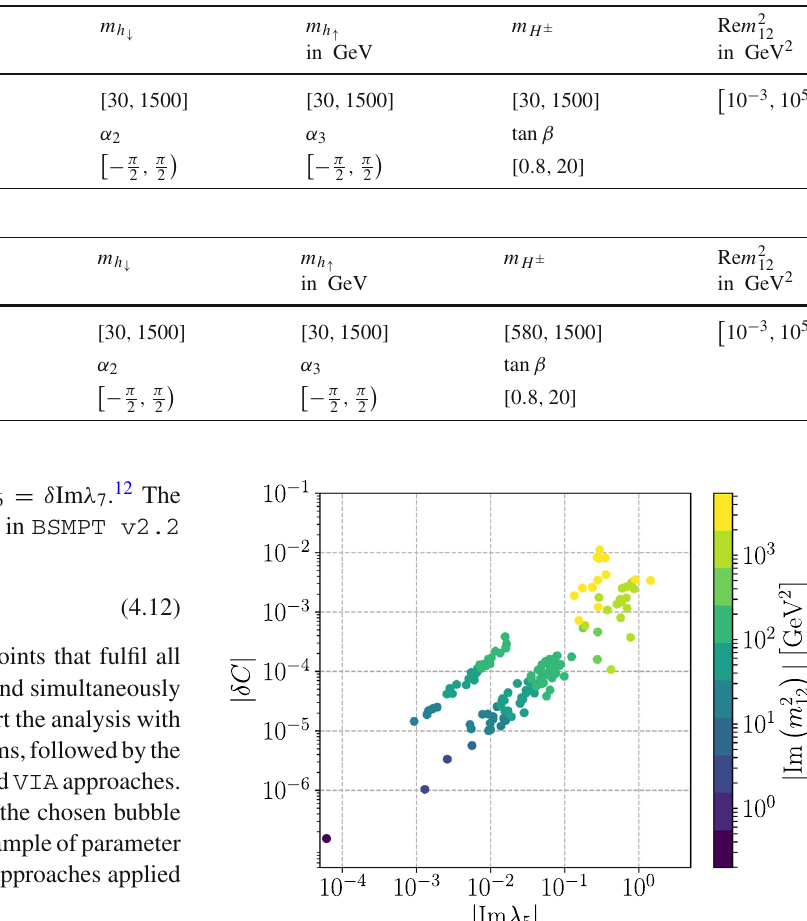
Table 2 Parameter ranges for the C2HDM TI input parameters used in ScannerS